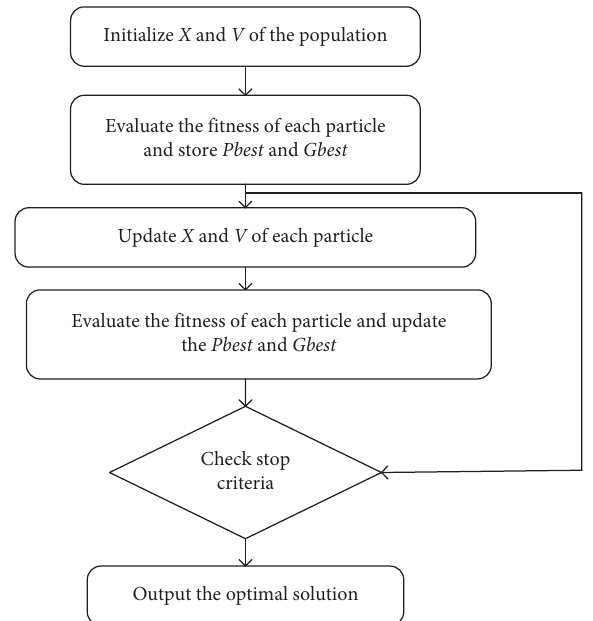
Figure 1: Flowchart of the standard PSO algorithm.